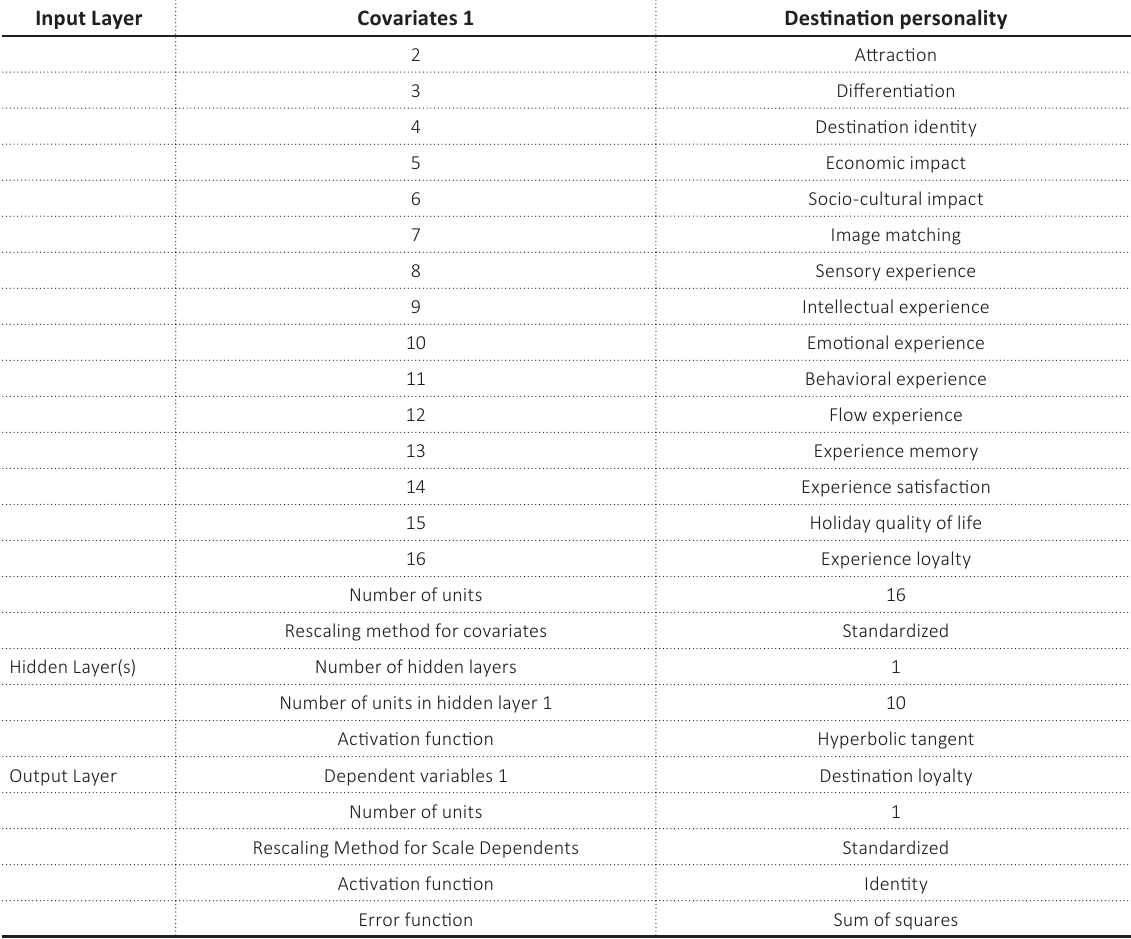
Table 3. Network information